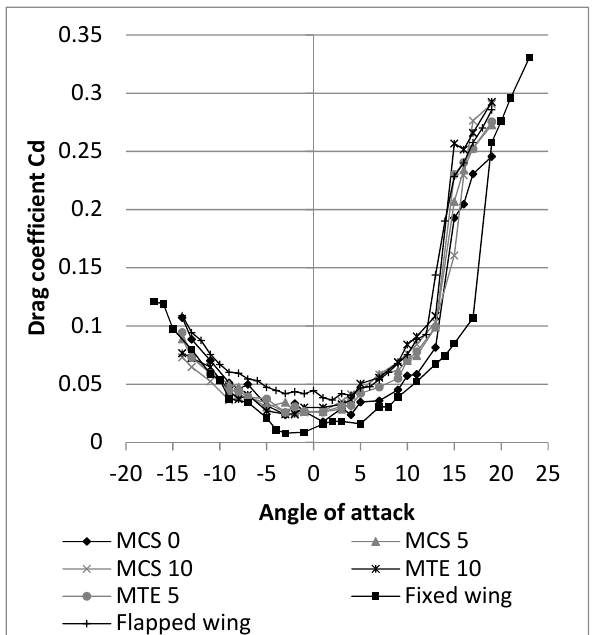
Figure 16. Drag coefficient variation with angle of attack.